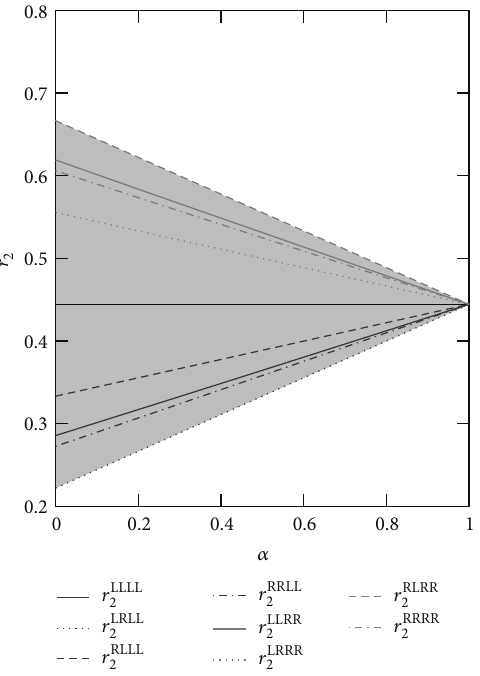
Figure 8: Solution candidates for 𝑟 1 (𝛼) . Figure 9: Solution candidates for 𝑟 2 (𝛼)